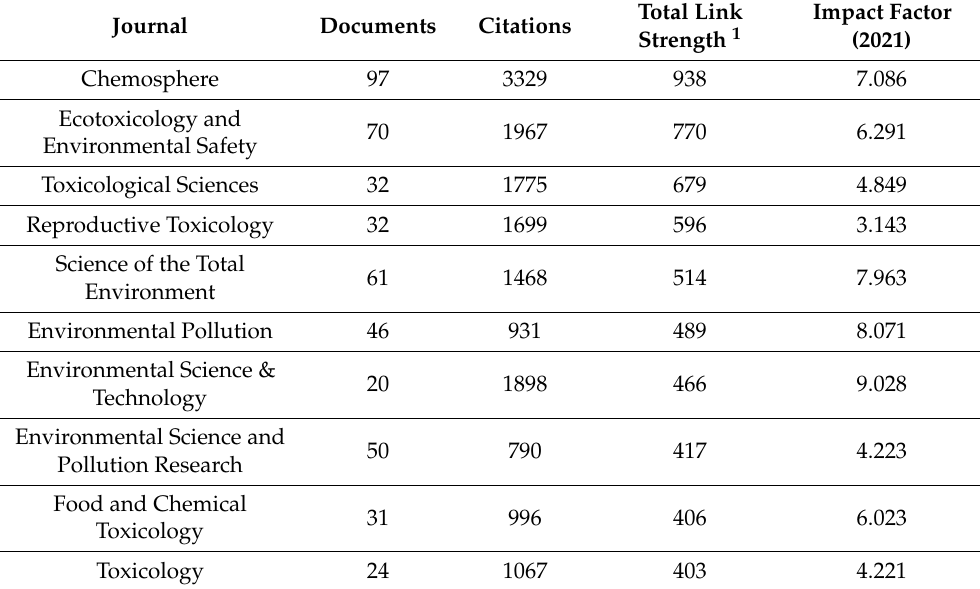
Table 3. The number of documents and citations of top 10